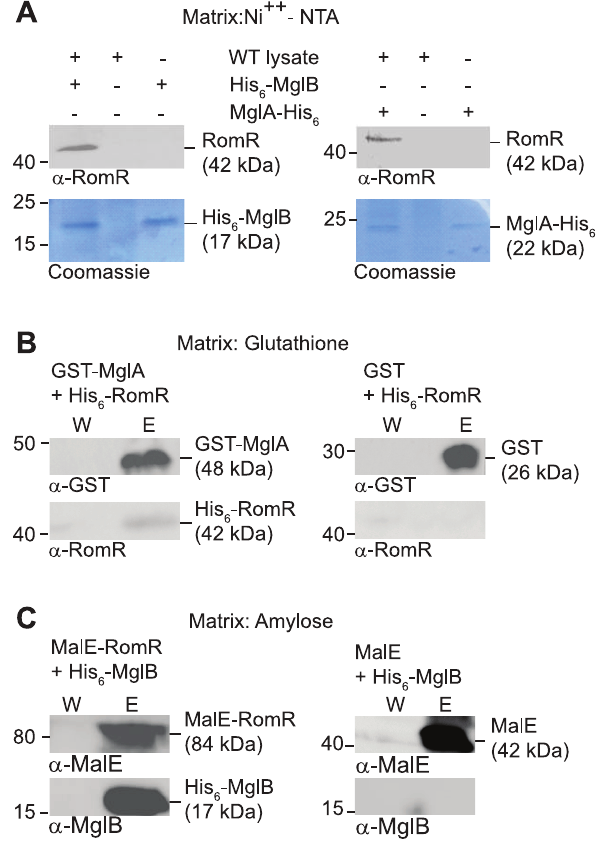
Figure 5. RomR interacts directly with MglA and MglB. (A) RomR interacts with His 6 -MglB and MglA-His 6 . WT M. xanthus cell extract was applied to a Ni ++ -NTA-agarose column with or without bound His 6 -MglB (left) and with or without MglA-His 6 (right). Eluted proteins were separated by SDS-PAGE and visualized in immunoblots with a -RomR (upper panels) or by Coomassie Brilliant Blue R-250 staining (lower panels). Positions of His 6 -MglB, MglA-His 6 and RomR including their calculated molecular masses are indicated. Migration of molecular weight markers in kDa is indicated on the left. (B) RomR interacts directly with MglA. Purified His 6 -RomR was applied to a glutathione- agarose column with bound GST-MglA (left) or with bound GST (right). Shown are proteins from the last wash fraction before elution (W) and from the elution (E). Eluted proteins were separated by SDS-PAGE and visualized in immunoblots with a -GST (upper panels) and a -RomR (lower panels). GST- MglA and His 6 -RomR including their calculated molecular masses are indicated. Migration of molecular weight markers in kDa is indicated on the left. (C) RomR interacts directly with MglB. Purified His 6 -MglB was applied to an amylose-agarose column with bound MalE-RomR (left) or with bound MalE (right). Shown are proteins from the last wash fraction before elution (W) and from the elution (E). Eluted proteins were separated by SDS-PAGE and visualized in immunoblots with a -MalE (upper panels) and a -MglB (lower panels). MalE-RomR, His 6 -MglB and MalE including their calculated molecular masses are indicated. Migration of molecular weight markers in kDa is indicated on the left. doi:10.1371/journal.pgen.1002951.g005 localized whereas MglA-GDP is not. We found that correct localization of the three proteins is mutually dependent in all three pair-wise interactions. Moreover, pull-down experiments using purified proteins and WT M. xanthus cell extracts or direct interactions studies with purified proteins together with previous results [26–28] show that the three proteins interact in all three pair-wise directions.